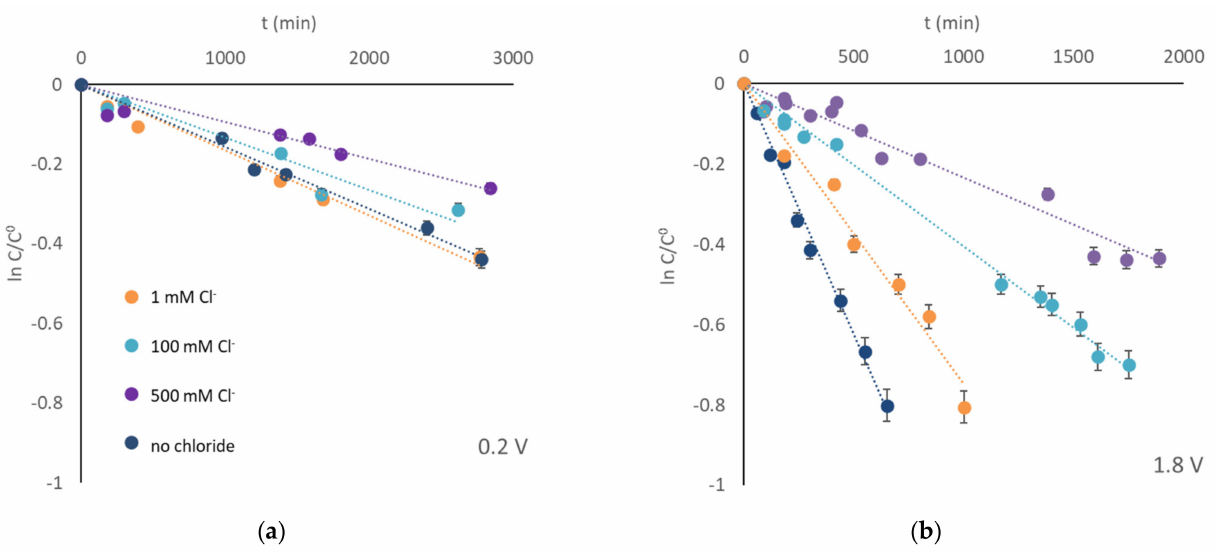
Figure 3. Trends with time of lnC/C 0 during photoelectrochemical degradations using solutions containing 40 mg dm − 3 DEP, 0.1 M NaClO 4 , and different chloride concentration. ( a ) Applied potential: 0.2 V; ( b ) applied potential: 1.8